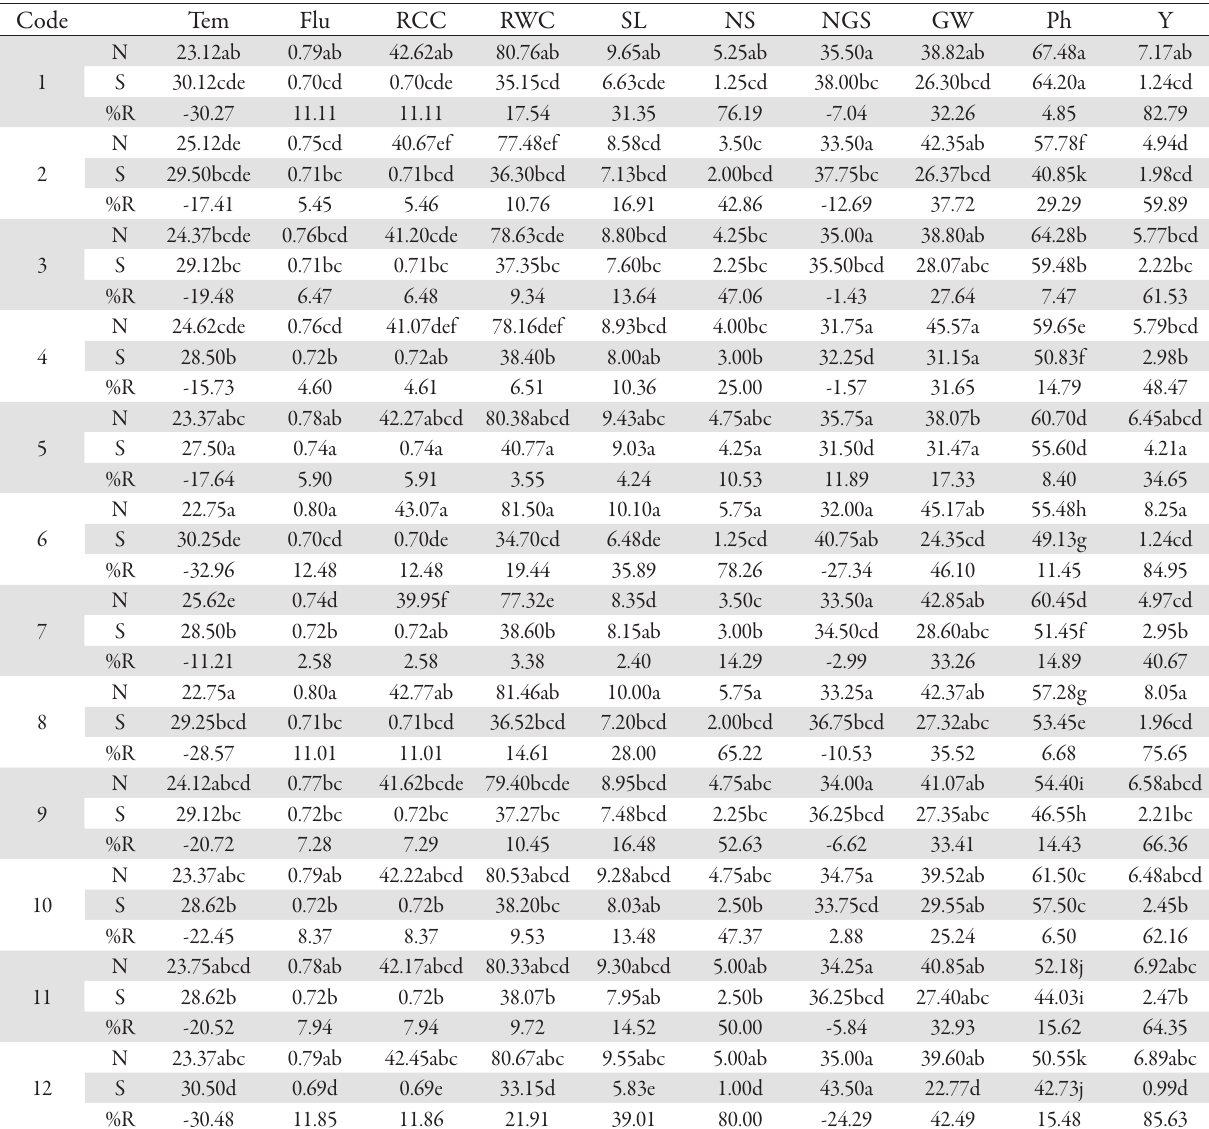
Tab. 3. Mean of agro-morphological and physiological characteristics in genotypes and landraces of barley under normal (N) and water deficit stress (S) conditions and percent of reduction